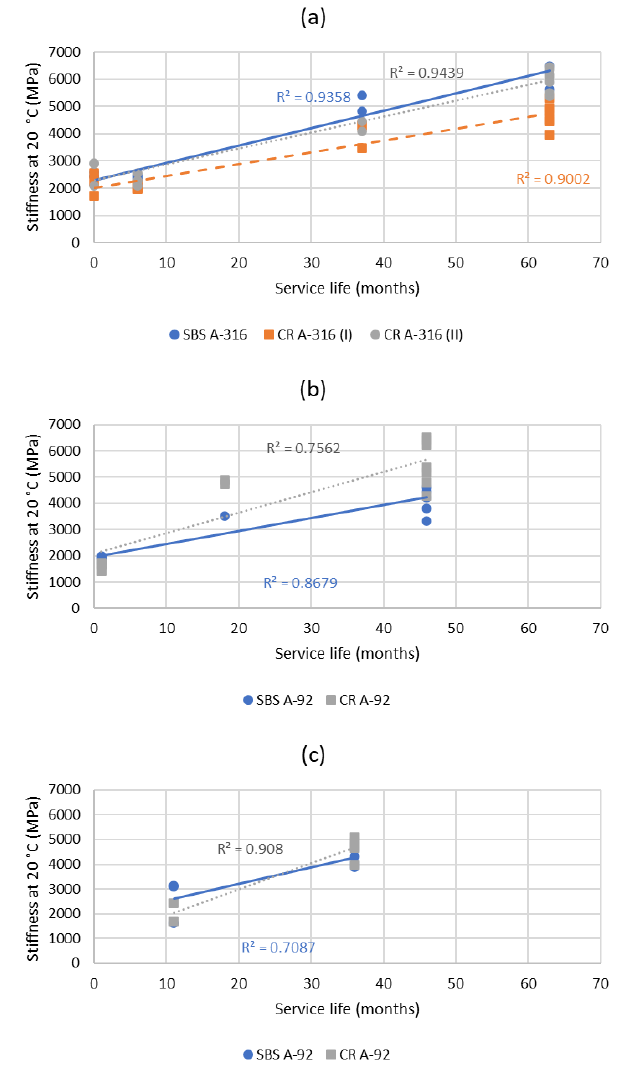
Figure 8. Evolution of the stiffness measured in the cores obtained along the service life of the highway sections studied: ( a ) A-316; ( b ) A-92-I; ( c ) A-92-II.